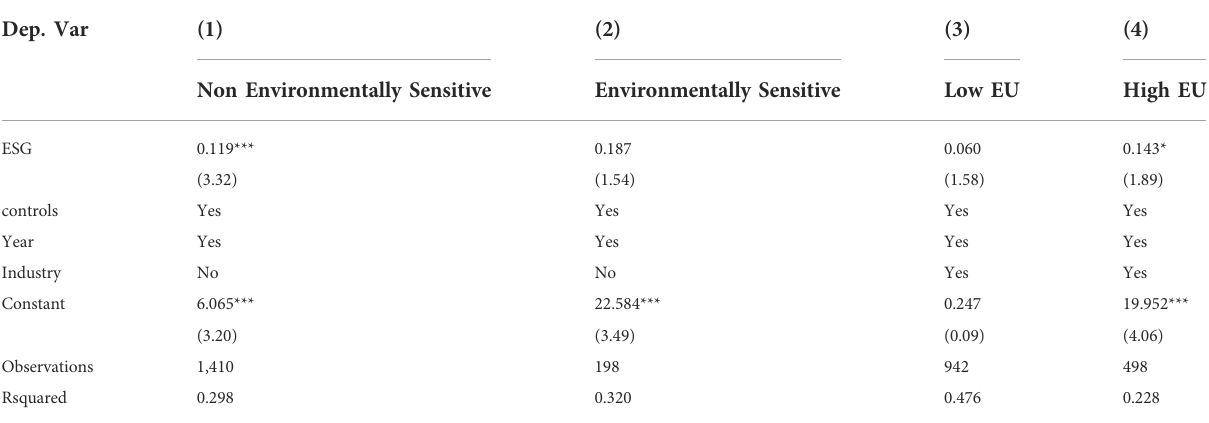
TABLE 8 Group regression